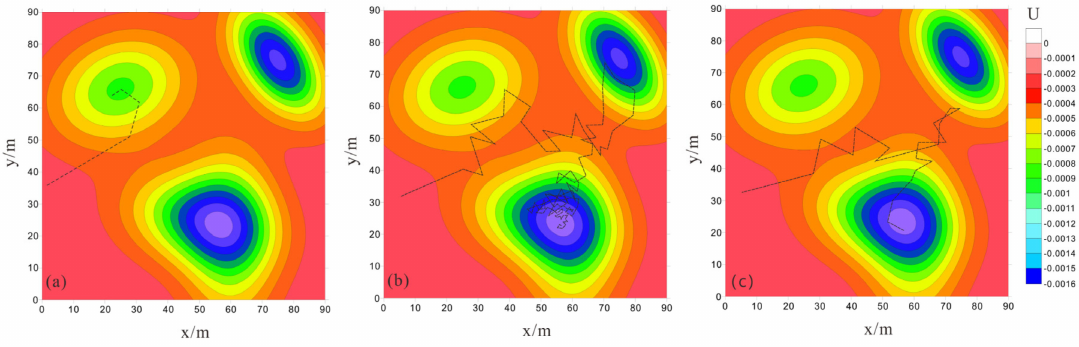
Figure 3. Optimization paths of the ( a ) GD, ( b ) PSO, and ( c ) PSO-GD algorithms.